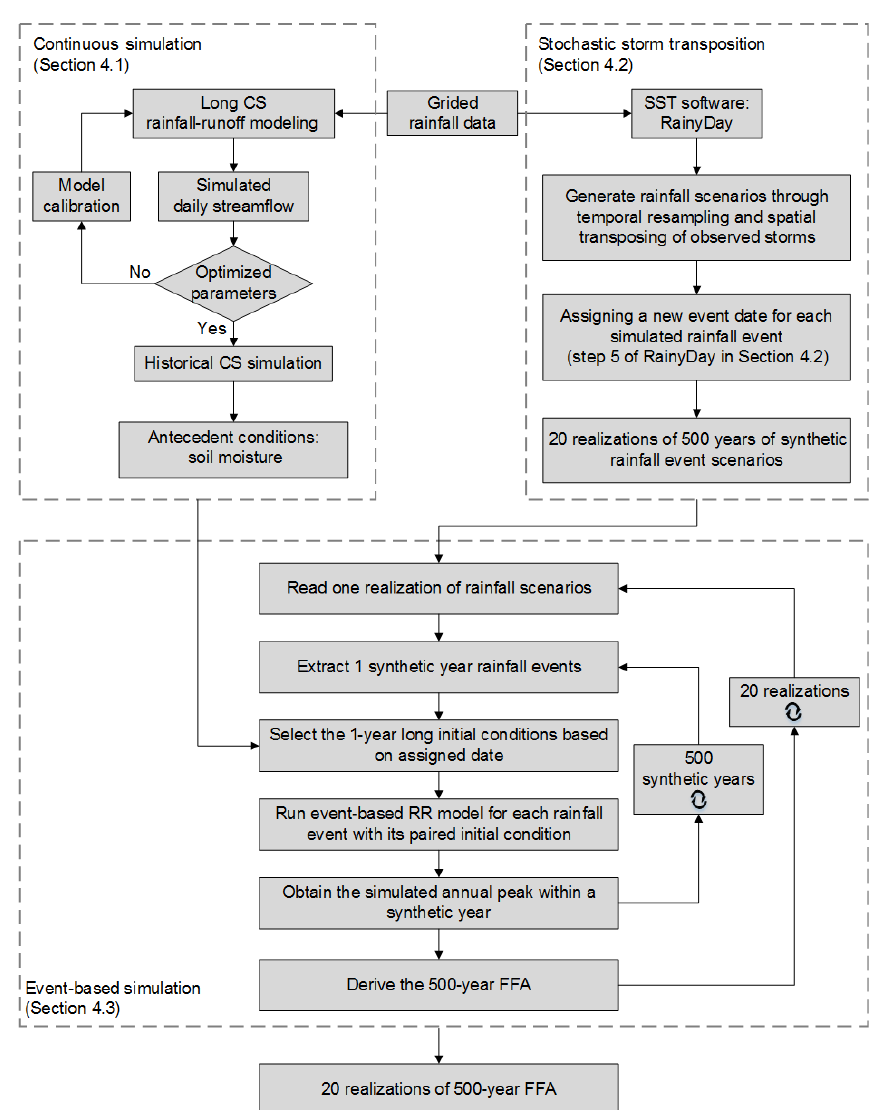
Figure 2. Flowchart showing the process-based FFA approach. Dotted outlines delineate components associated with Sects. 4.1, 4.2, and